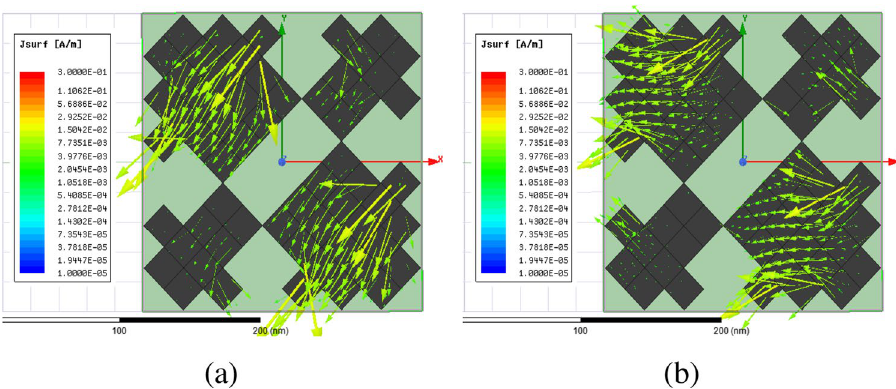
Figure 5. Surface current on the surface of the first structure at ( a ) 34.12 THz and ( b ) 35.44